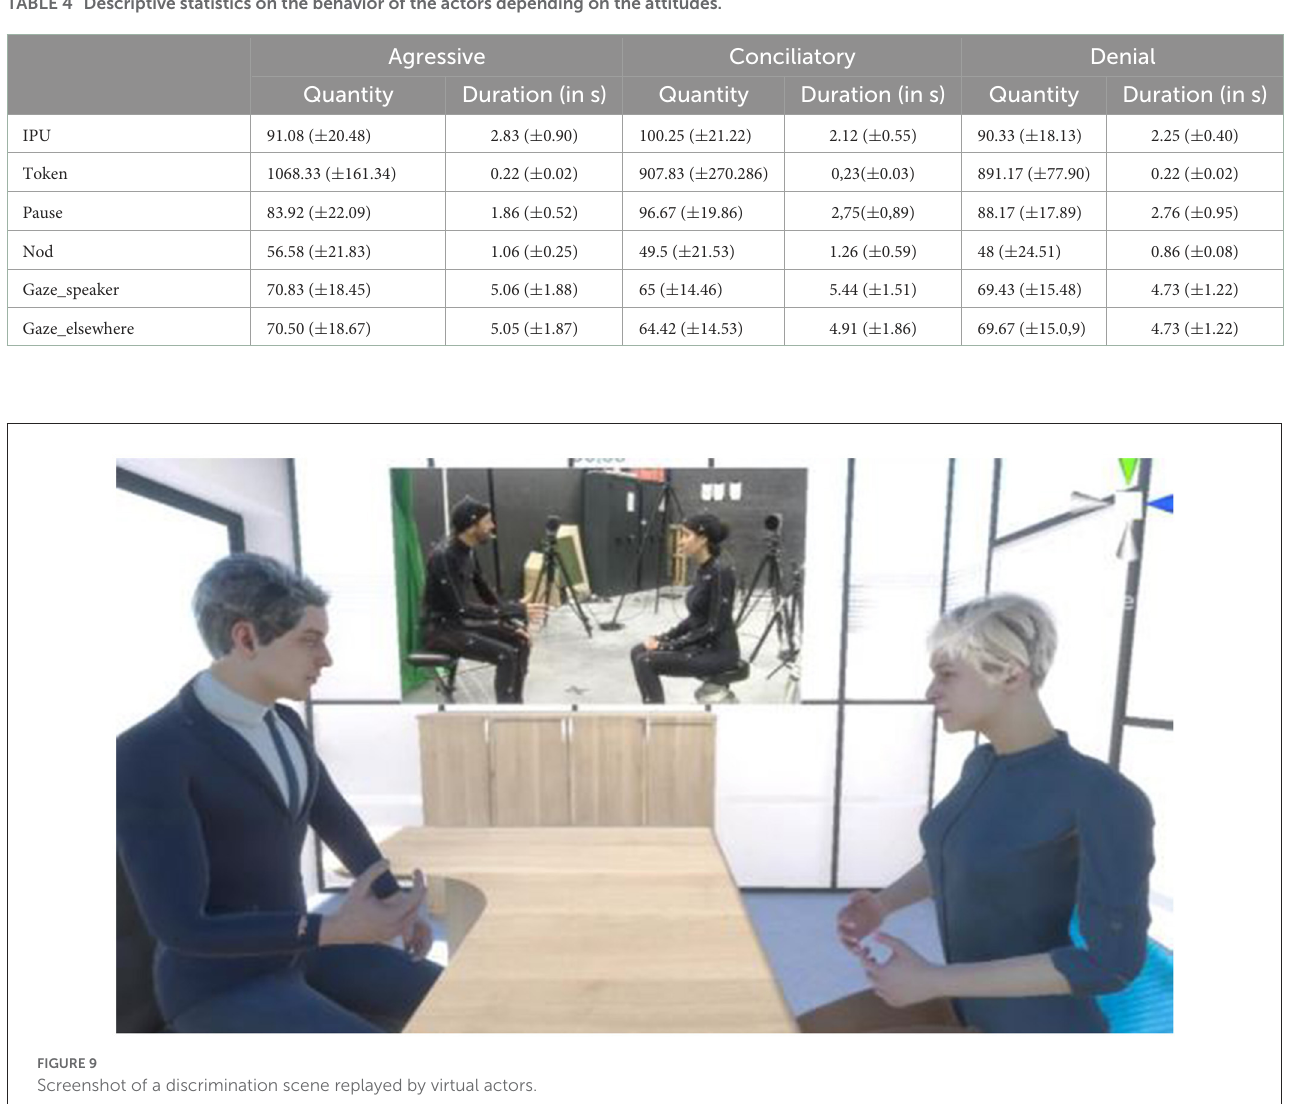
interpreted by a slower speech rate, which is coherent with a more calm